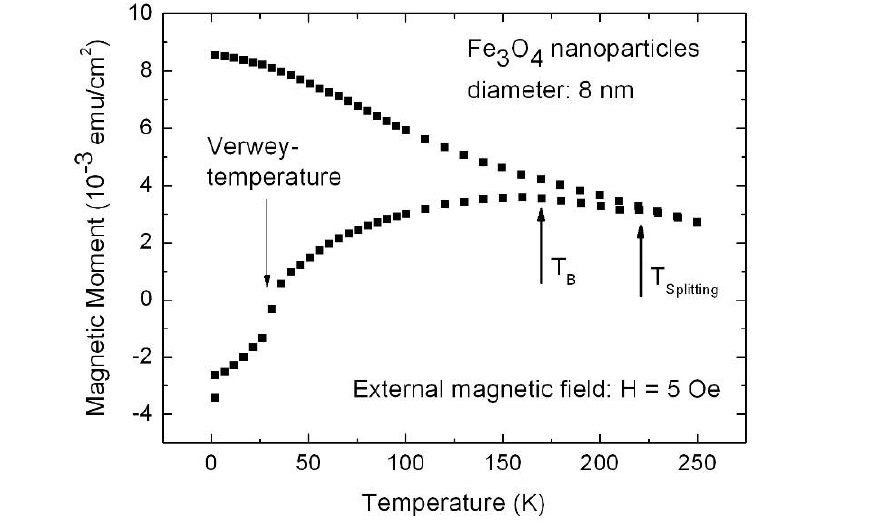
Figure 41. Temperature dependent magnetization measurements of Fe exhibiting a blocking temperature at 160 K and a bifurcation of the two branches (ZFC/FC) at 230 K (reproduced by permission of The Electrochemical Society